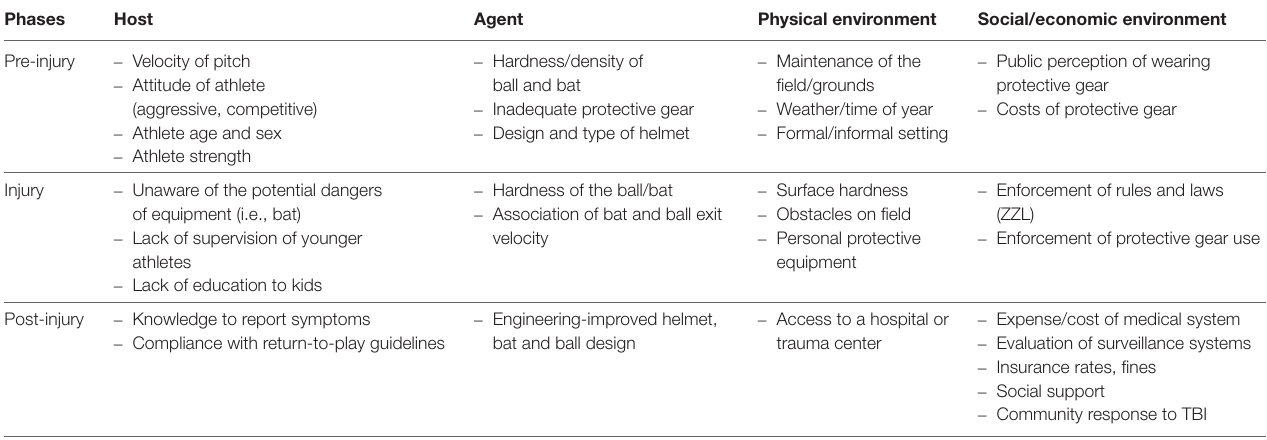
taBLe 7 | Haddon’s Matrix for prevention